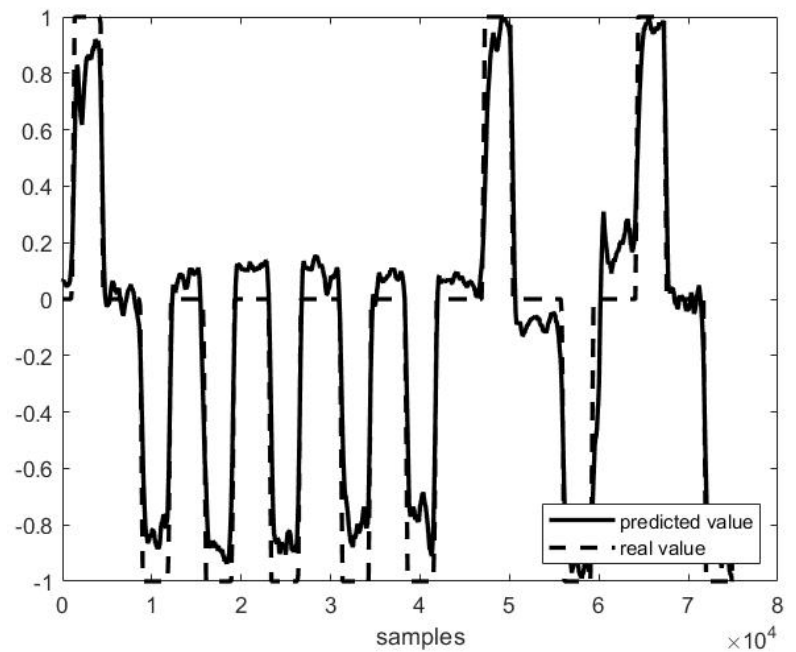
Figure 5. Predicted vs. actual values in P4 F1 testing ( r = 0.98 and MSE = 0.02).